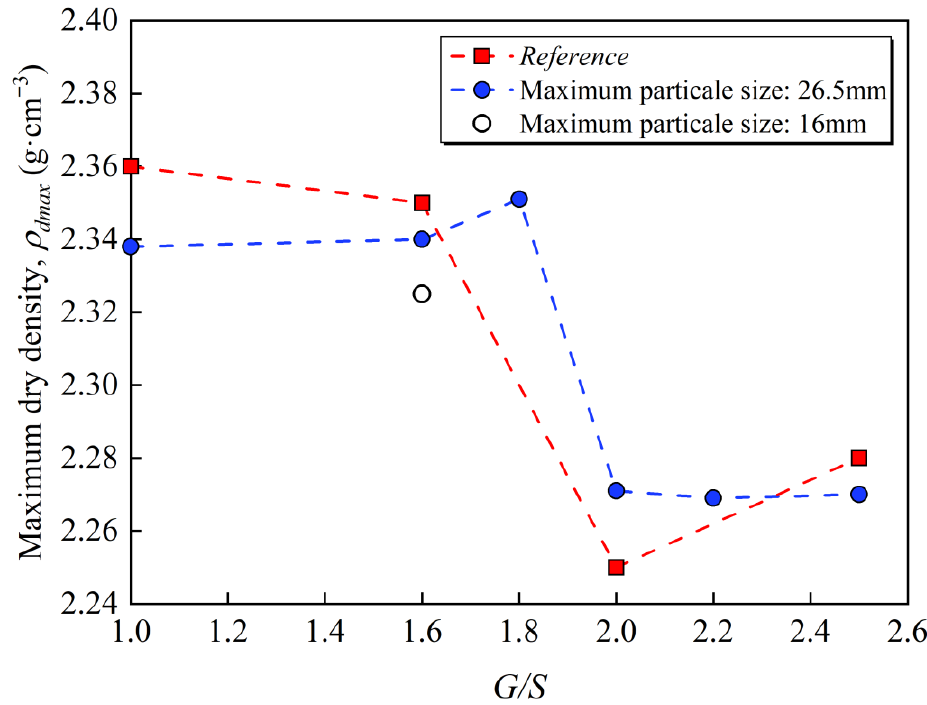
Figure 5. The achieved maximum dry density values were plotted against G / S values of UPAB specimens from proctor compaction tests.